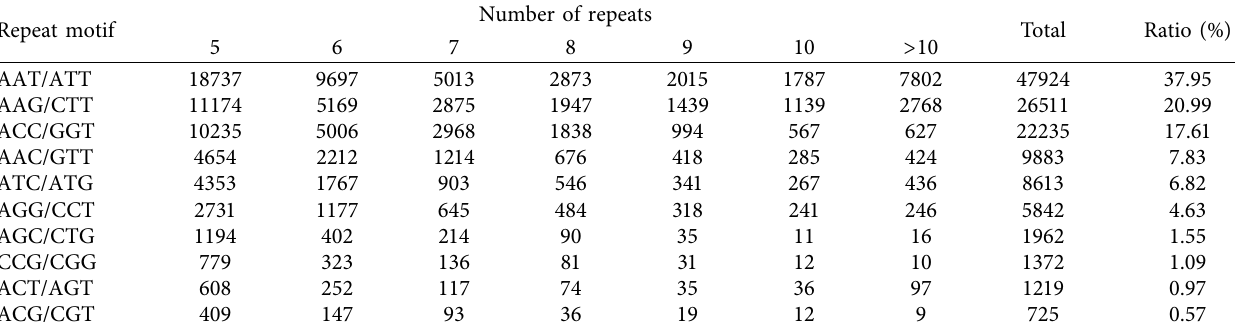
Table 6: Statistics of trinucleotide 126, 286 motifs.